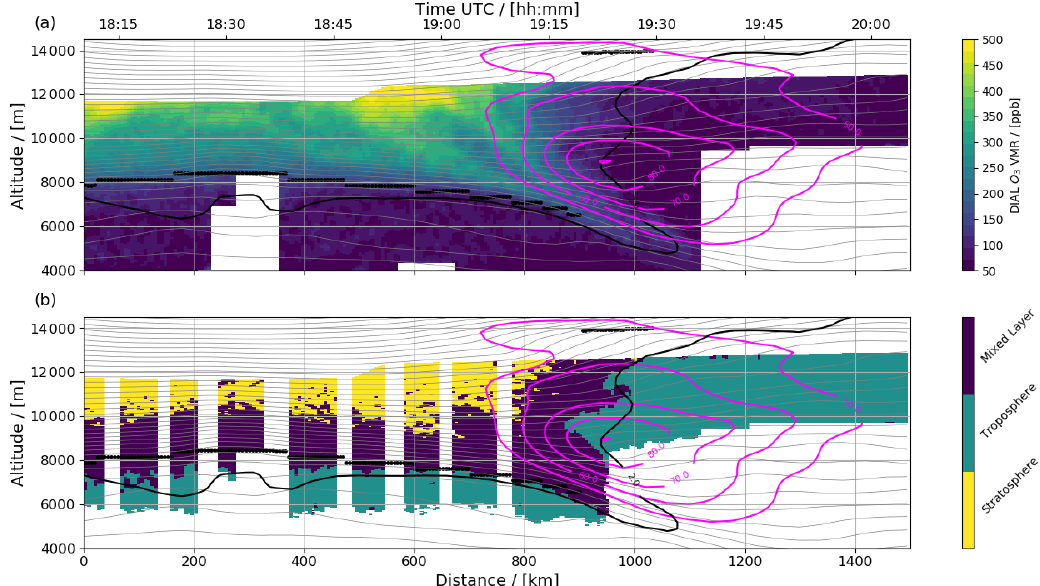
Figure 10. Vertical cross sections as in Fig. 4 but for (a) DIAL ozone volume mixing ratio (in ppb) and (b) air mass classes derived from water vapour and ozone measurements (for details, see Sect.